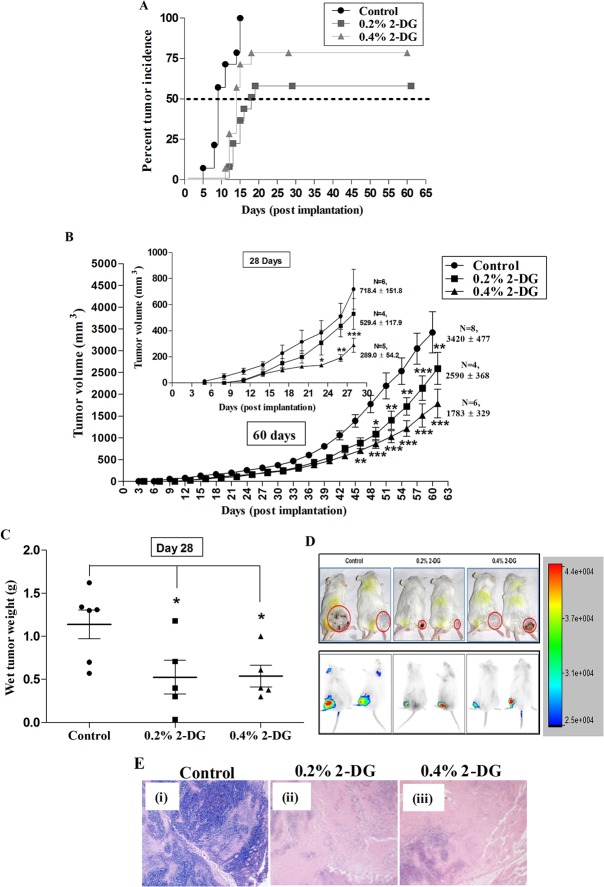
Dietary 2-DG significantly inhibited the process of tumorigenesis in transplanted Erhlich ascites carcinoma (EAC) tumor model.(A) Tumor latency (palpable) and incidence, (B) Tumor volume, (C) Tumor weight (day 28), (D) Representative photographs of animals showing differences in the tumor size (upper panel) and in-vivo optical images (lower panel). Intensity of the signals showing the NIR-dye tumor specific uptake in mice from each treatment group demonstrating tumor burden (day 28), (E) Representative photomicrographs of histological analysis (H & E staining) showing intra-tumoral morphology of EAC tumors from (i) Control, (ii) 0.2% 2-DG and (iii) 0.4% 2-DG mice. *, p < 0.05; **, p < 0.01; ***, p < 0.001